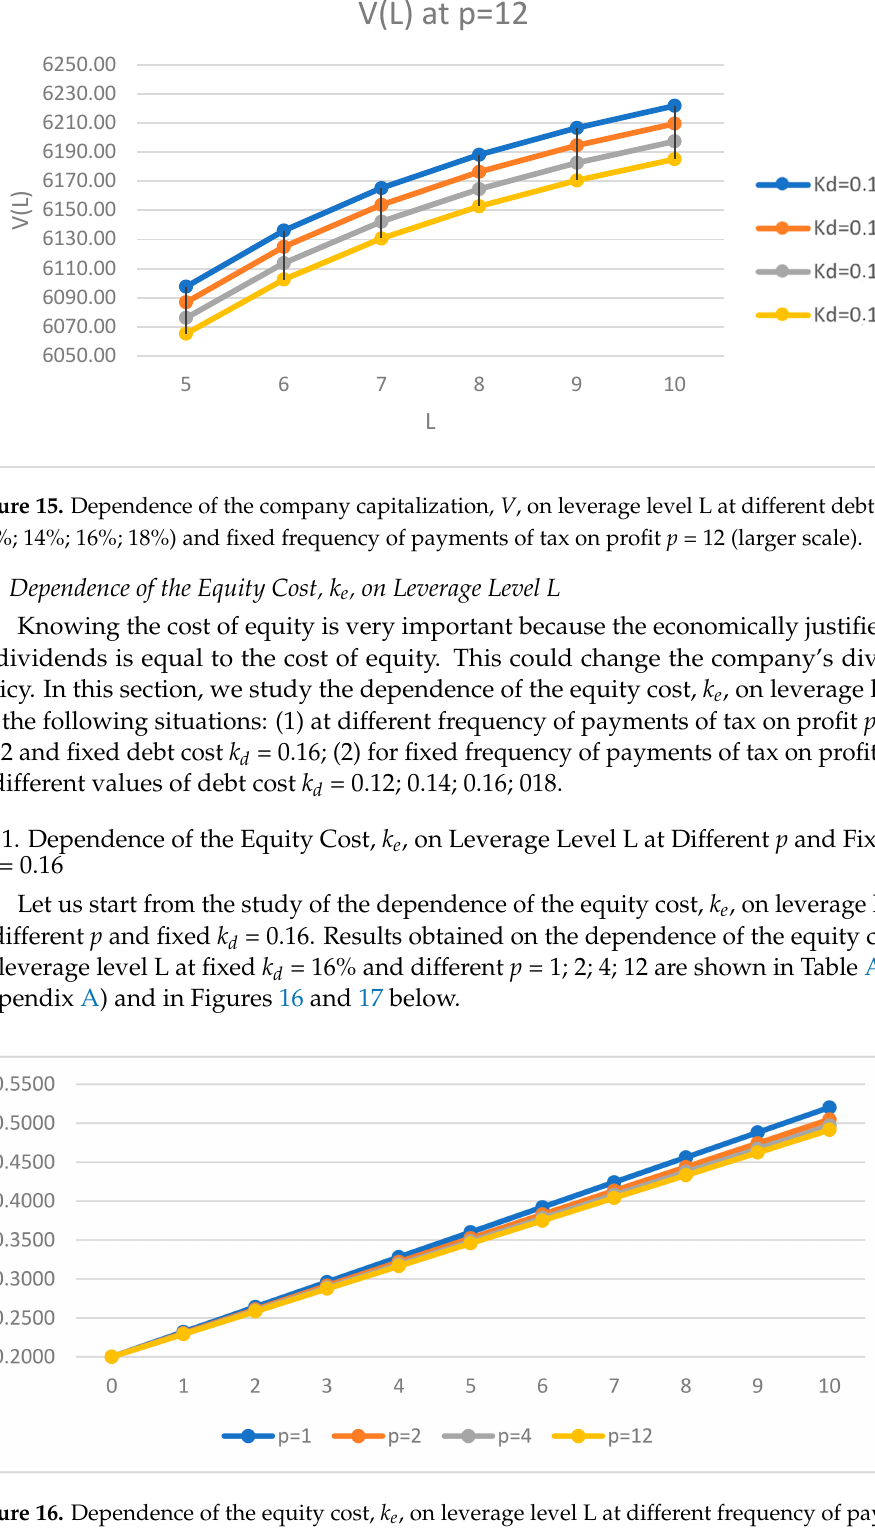
of tax on profit p (1; 2; 4; 12) and fixed debt cost k d =